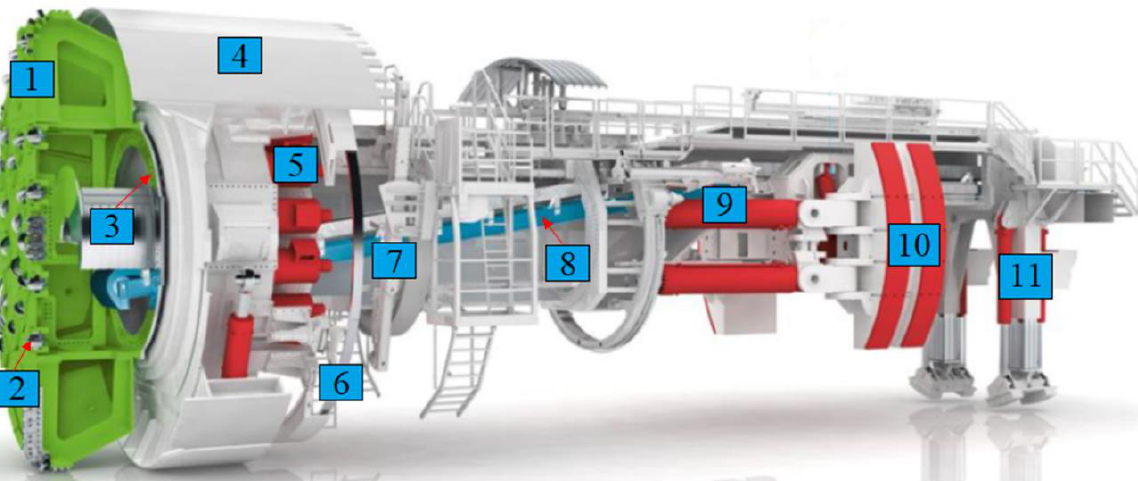
Figure 1. Diagram of main structure of an open-type girder TBM (1. Cutterhead; 2. Disc cutter; 3. Spindle; 4. Top shield; 5. Cutterhead drive motor; 6. Steel arch assembly machine; 7. Jumbolter; 8. Belt conveyor; 9. Thrust cylinder; 10. Gripper; 11. Back support).